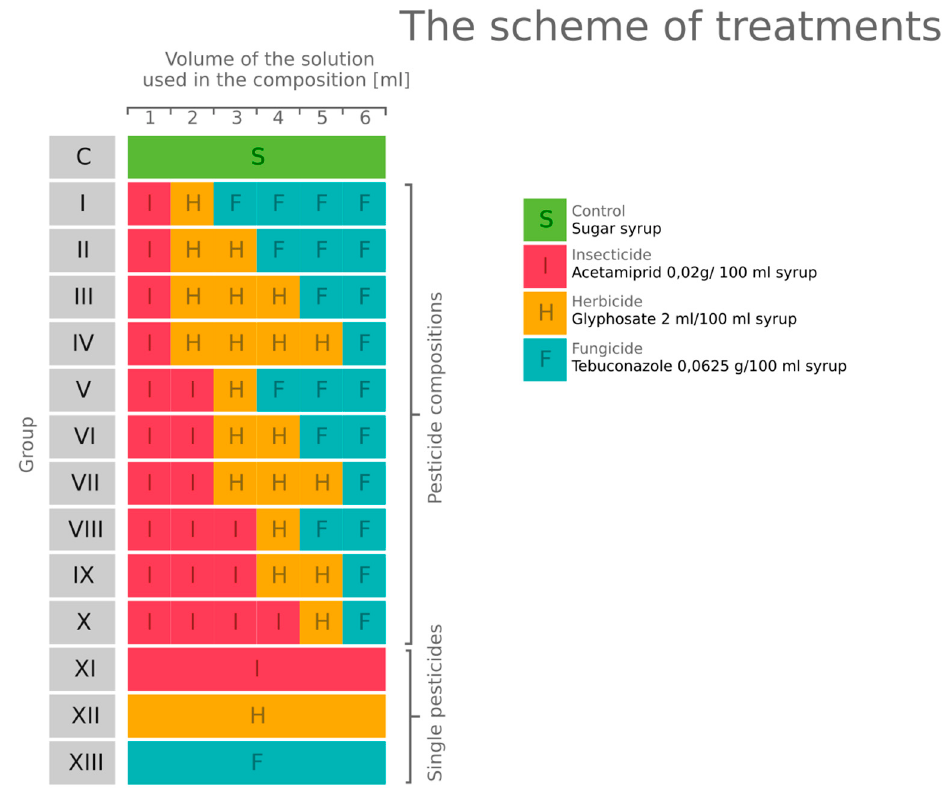
Figure 1. The scheme of treatments. Each group was fed ad libitum with a solution of a total volume of 6 mL. The solution composition differed between groups. The group abbreviated as C was a control group, fed with 50% ( w / v ) sucrose solution. Groups XI–XIII were fed with single pesticides dissolved in 50% ( w / v ) sucrose solution. Groups I-X were fed with pesticide compositions consisting of each type of pesticide in varying proportions.